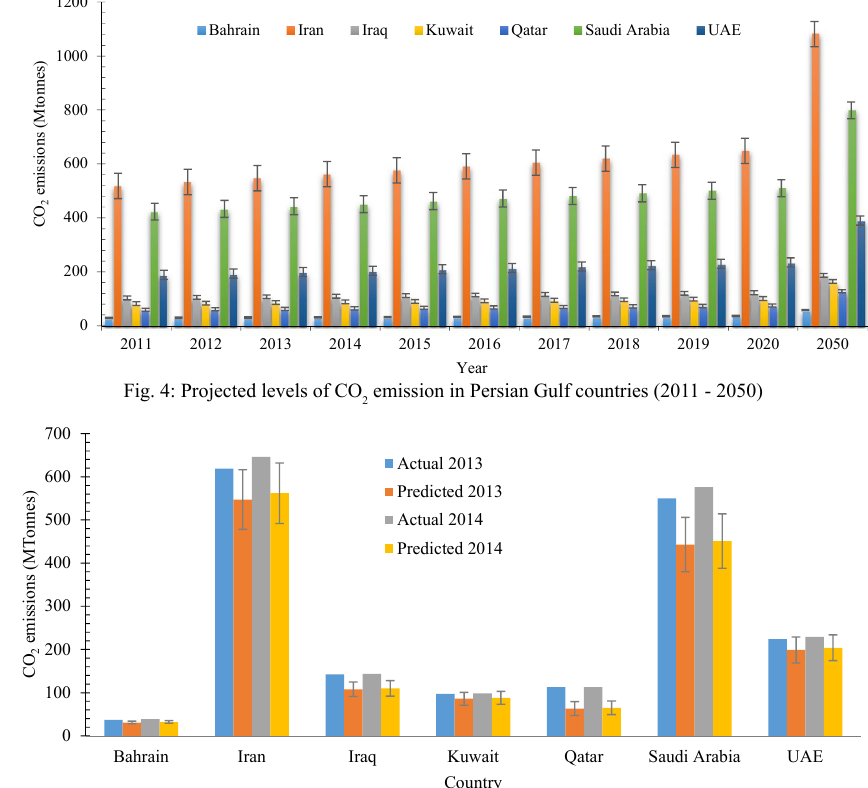
Fig. 5: Comparing actual and predicted CO